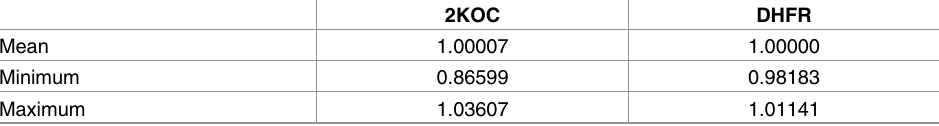
Values are the normalized projection of the CHARMM forces ( F C ) onto the OpenMM forces ( F O ): ( F C (cid:1) F O )/ ( F O (cid:1) F O ). The mean, minimum, and maximum are taken over all